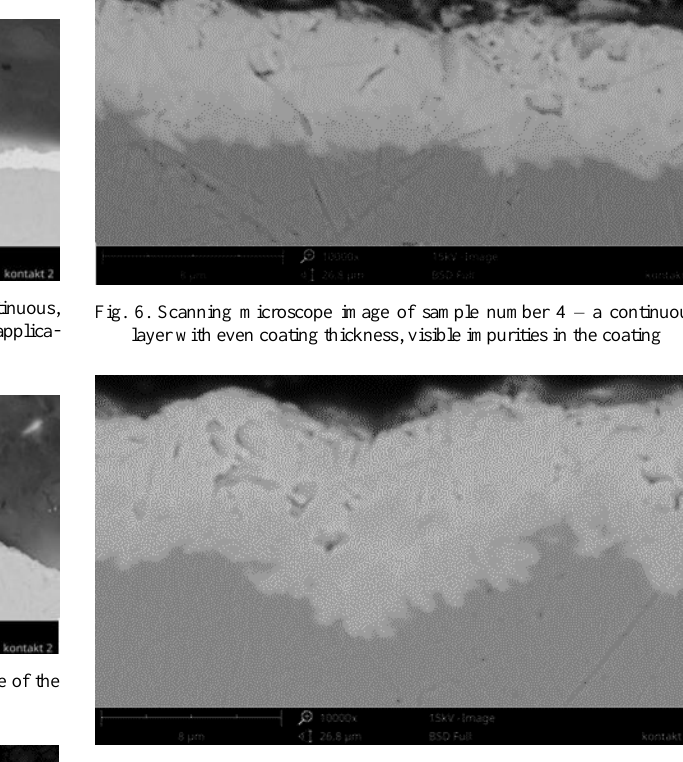
Fig. 7. Scanning microscope image of sample number 4 – a continuous layer with uneven coating thickness. Coating material with numerous irregularities